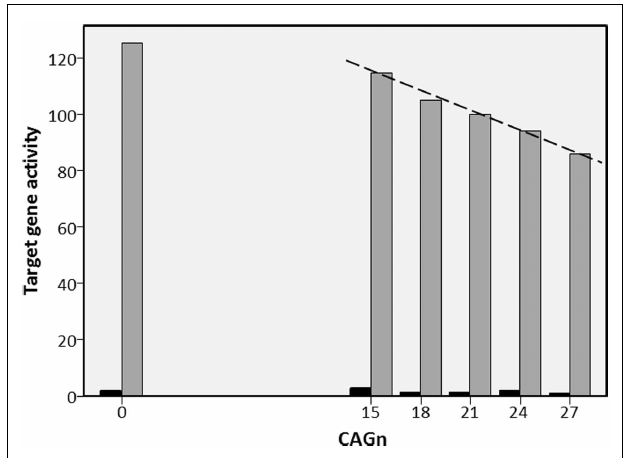
FIGURE 1 | Fictitious example of in vitro study into the effect of CAGn on target gene activity . Example for regression of the activity of a testosterone regulated target gene on CAGn in in vitro studies (cf. Table 1 ). ARs with CAGn of 0, 15, 18, 21, 24, or 27 are used either with testosterone (gray bars) or without testosterone (black bars).Target gene activity observed at CAGn most typical in humans (21) is set to 100%.Then the regression slope (dashed line, − 2.3%) is calculated to describe target gene activity as a function of CAGn. In cases like the present, where CAGn outside the human range produce a deviation from linearity (here 0 CAGn), the regression slope was calculated only for those CAGn that showed a linear function.